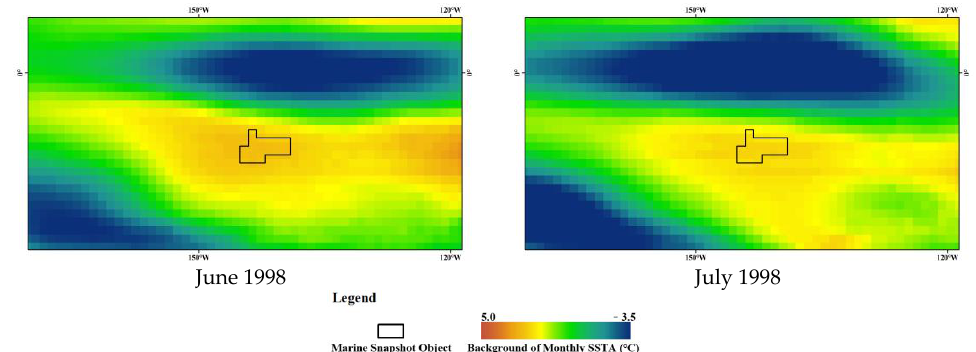
Figure 11. Sequence object 4 continues to decrease in the Equatorial Central Pacific Ocean from June to July 1998. The background is the monthly SSTA.